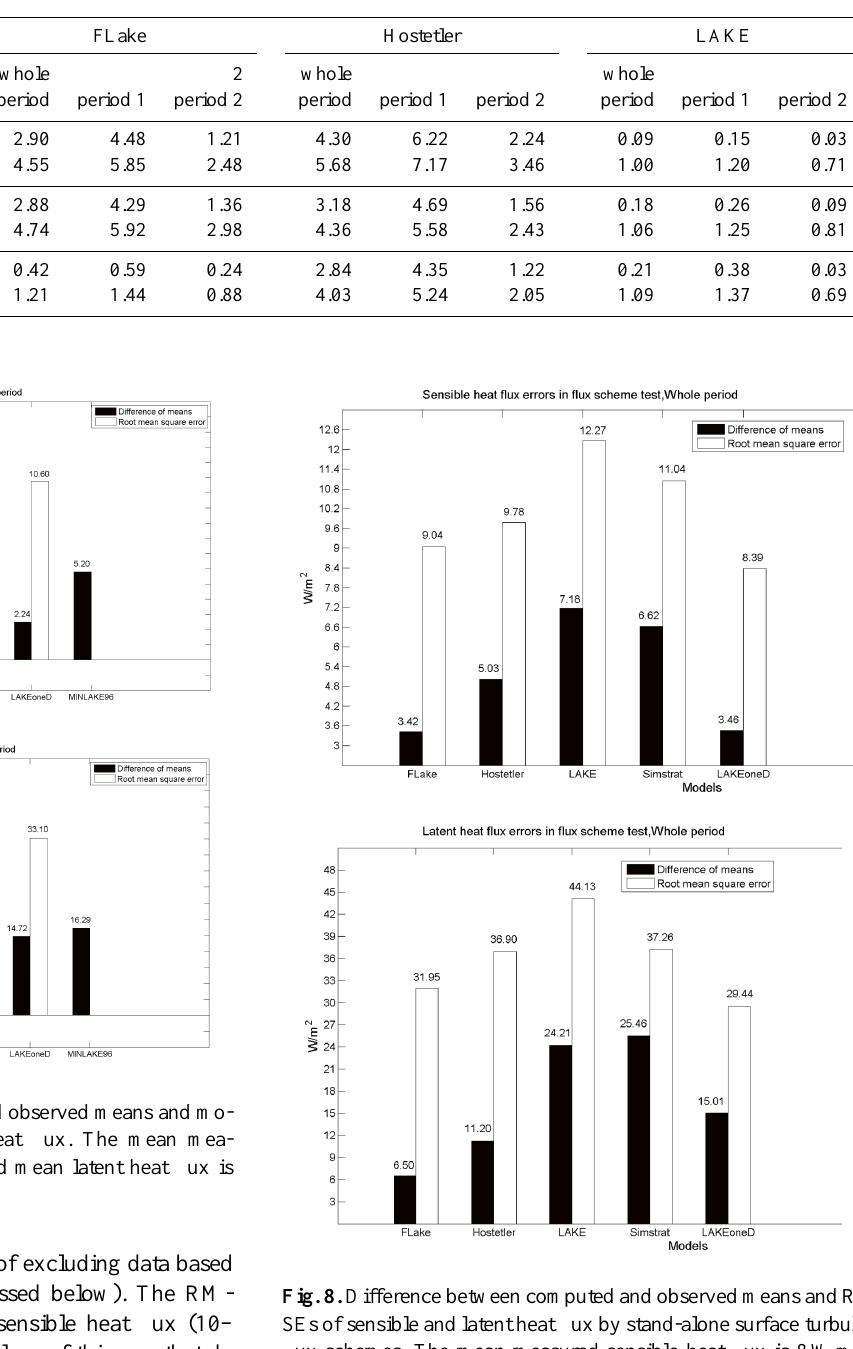
Table 5. The 0–1m temperature difference errors ( ◦ C) in model experiments when using different lake depths ( h ). The mean observed δT 0 − 1 is 0.50 ◦ C for the whole period, 0.72 ◦ C and 0.26 ◦ C for 1st and 2nd periods, respectively.